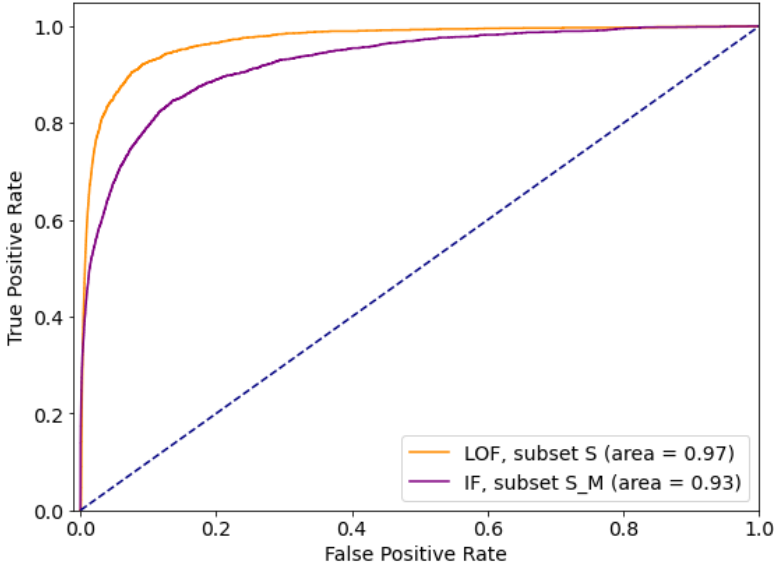
Figure 8. Extended PaySim dataset—comparative ROC curve for outlier detection methods.